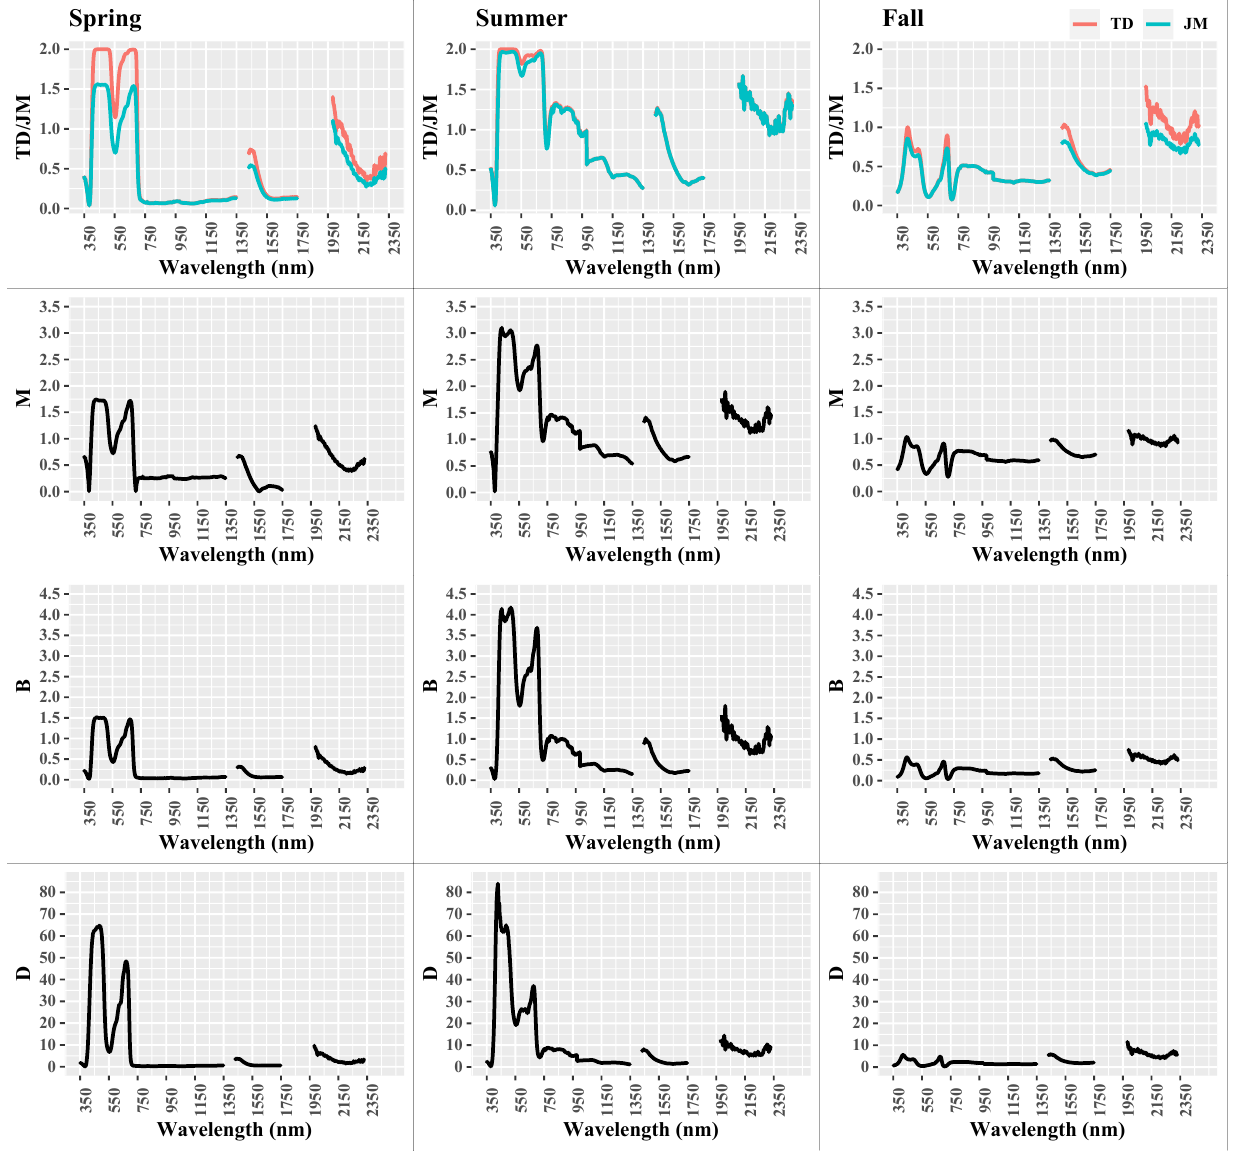
Figure 4. Seasonal spectral separability metric results between western snowberry and wolfwillow across all hyperspectral wavelengths (Transformed Divergence (TD), Jeffries–Matusita (JM) distance, M-Statistic (M), Bhattacharyya distance (B), Divergence (D); water absorption regions between 1350–1430 nm, 1750–1980 nm, and 2330–2500 nm have been